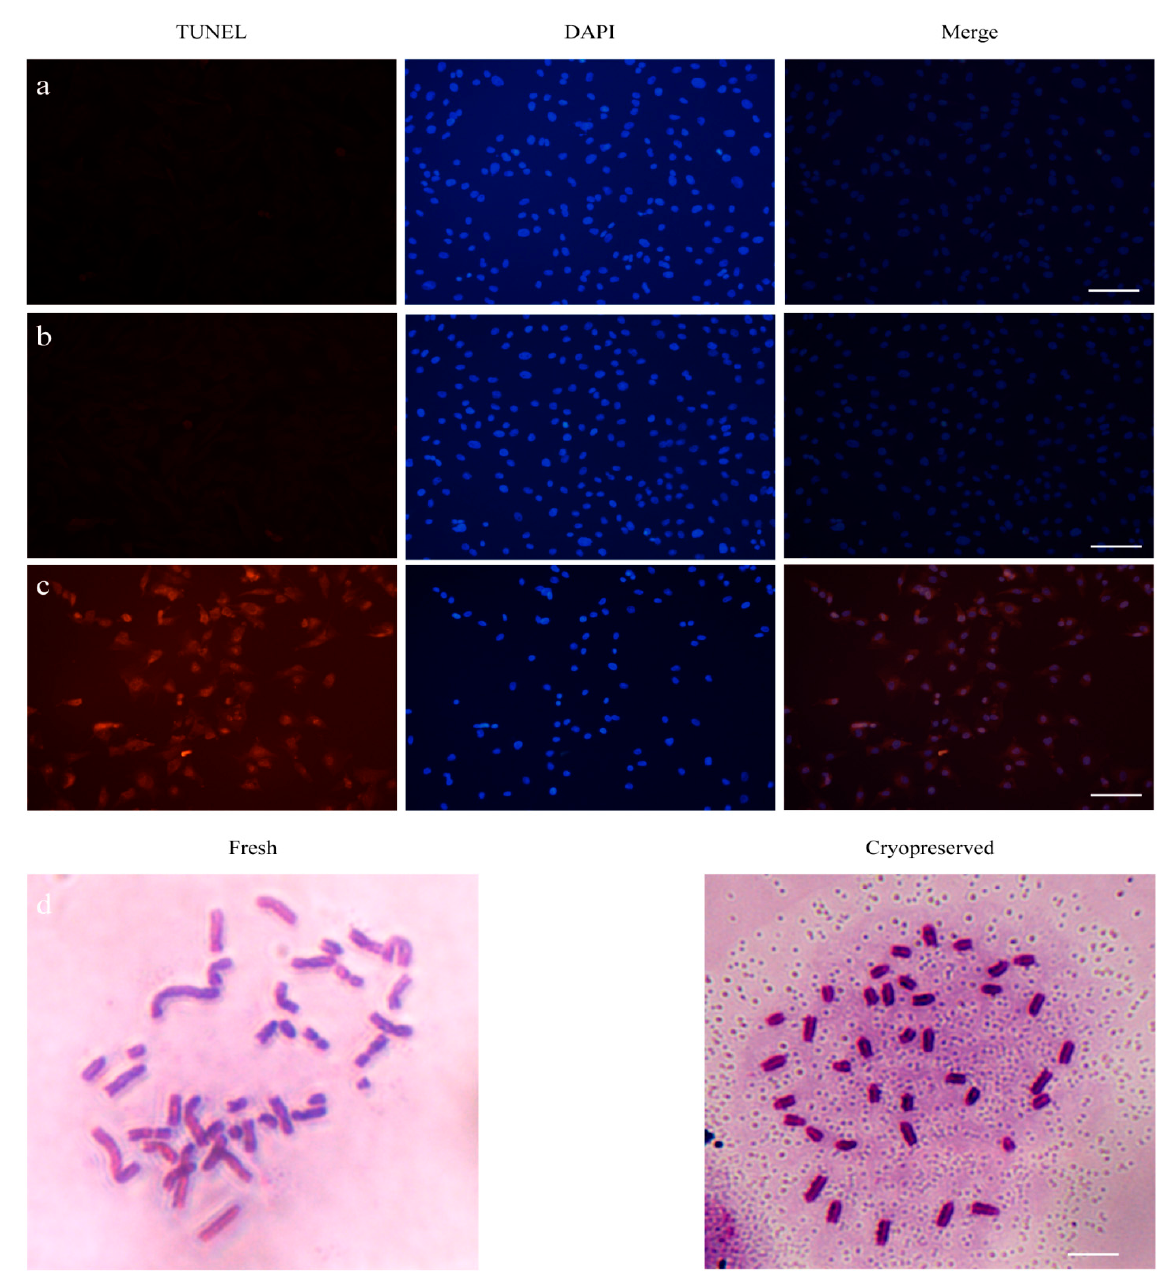
Figure 7. Effects of ear tissue vitrification on cell apoptosis and karyotype. Representative images of cells isolated from fresh tissues and cryopreserved tissues for TUNEL assay: ( a ) cells isolated from fresh tissues; ( b ) cells isolated from thawed tissues; ( c ) H 2 O 2 treated group. Scale bar = 200 µ m; ( d ) Representative images of cell karyotype, Scale bar = 50 µ